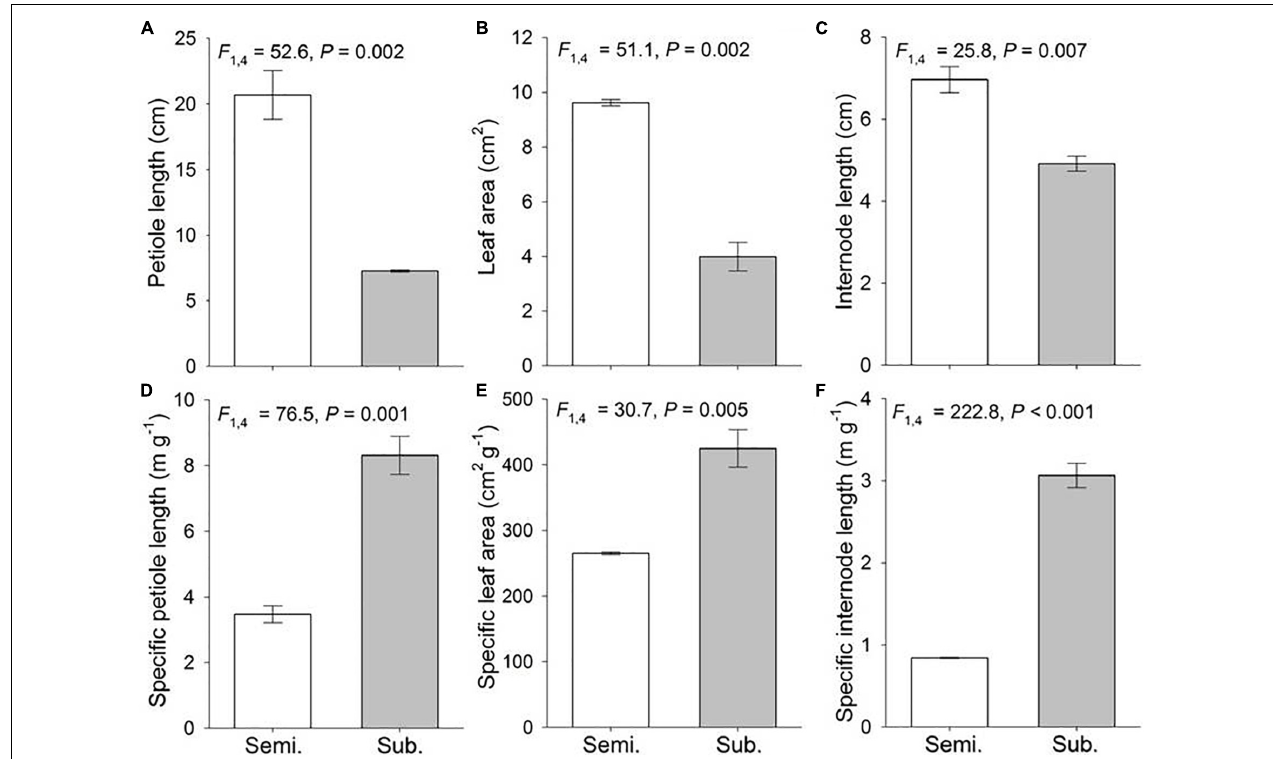
FIGURE 1 | Phenotypic traits of the Hydrocotyle vulgaris at population level under semi-submergence (Semi.) and submergence (Sub.). Phenotypic traits are (A) petiole length, (B) leaf area, (C) internode length, (D) specific petiole length, (E) specific leaf are, and (F) specific internode length. Mean ± SE are shown ( n = 3). F , P, and degree of freedom of nested ANOVAs are also